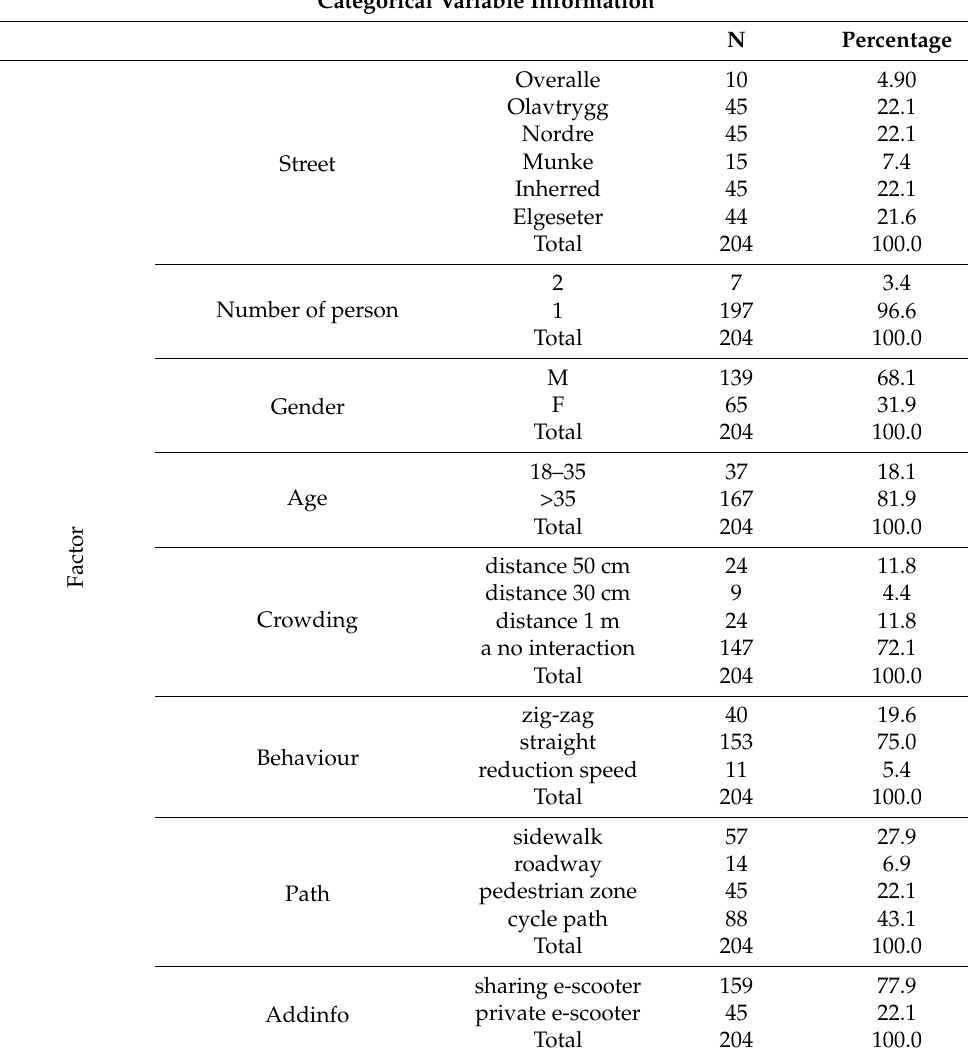
Table 4. Data collected by observer.